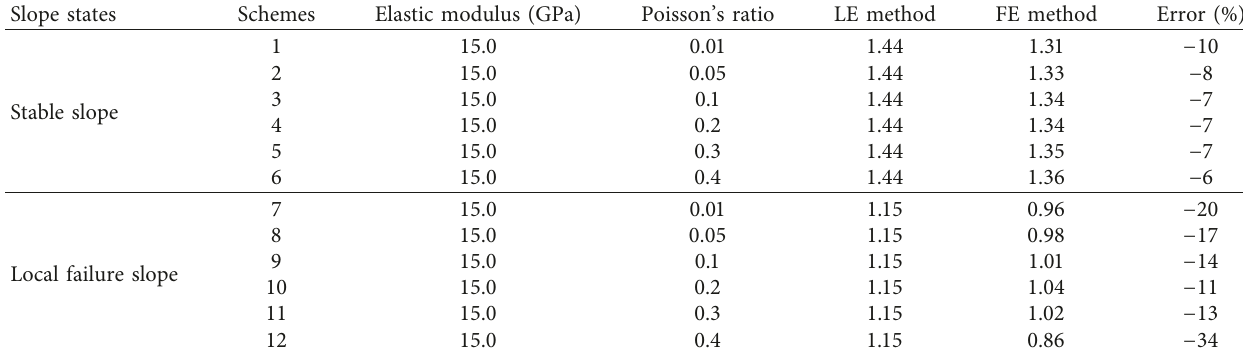
Table 8: Influence of sliding body Poisson’s ratio on safety factors and error